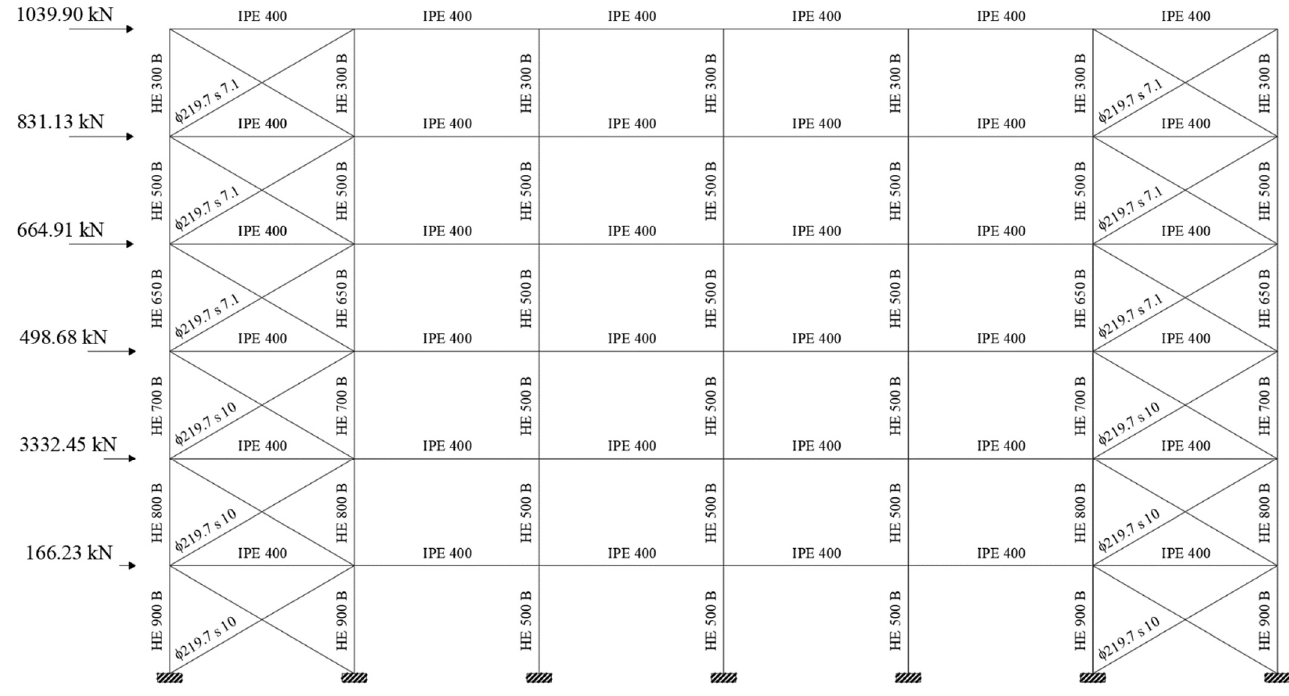
Figure 7. Diagram of the frame with indication of beams, diagonals, columns, and seismic forces (SCBF).